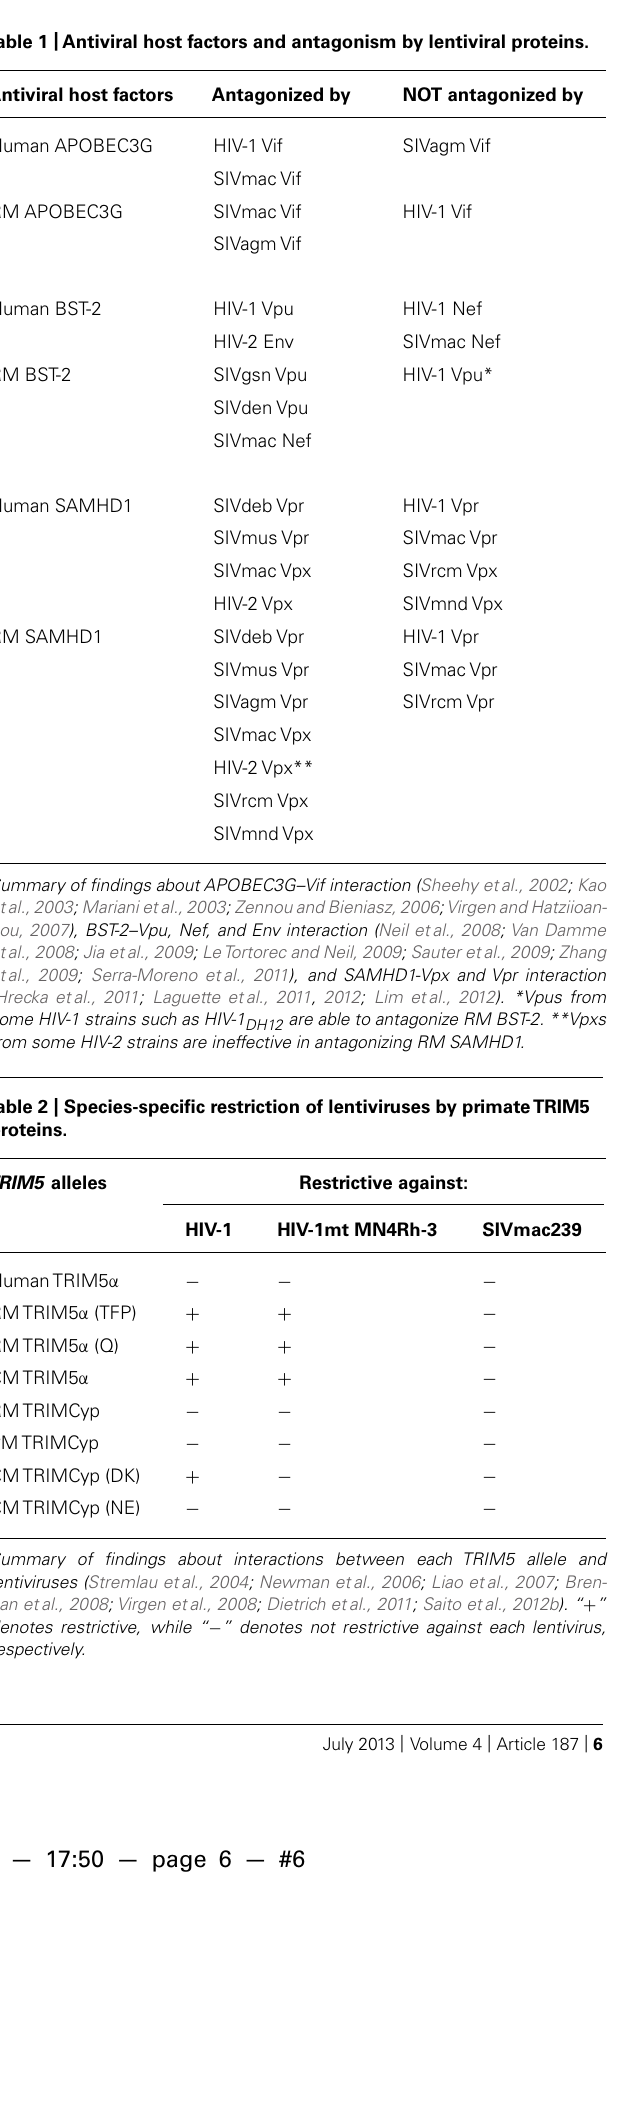
Table 1 |Antiviral host factors and antagonism by lentiviral proteins.